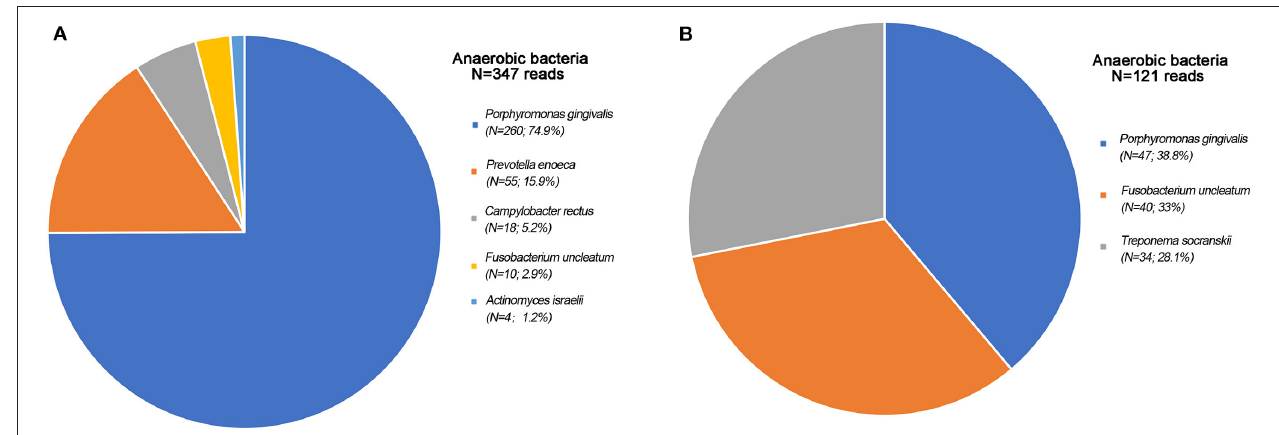
FIGURE 1 | Anaerobic bacteria found by mNGS. (A) Anaerobic bacteria found by mNGS first times. Porphyromonas gingivalis: 260 reads; Prevotella enoeca: 55 reads; Campylobacter rectus: 18 reads; Fusobacterium uncleatum: 10 reads; Actinomyces israelii: 4 reads; (B) Anaerobic bacteria found by mNGS second times. Porphyromonas gingivalis: 47 reads; Fusobacterium uncleatum: 40 reads; Treponema socranskii: 34 reads.